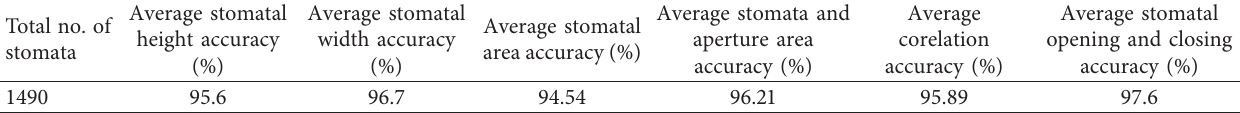
Table 1: Parameters measurements accuracy.